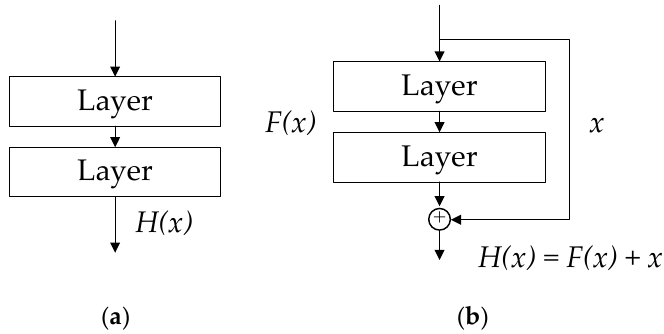
Figure 3. Comparison of deep learning network: ( a ) Normal deep-learning network; ( b ) Deep learning network with residual block.